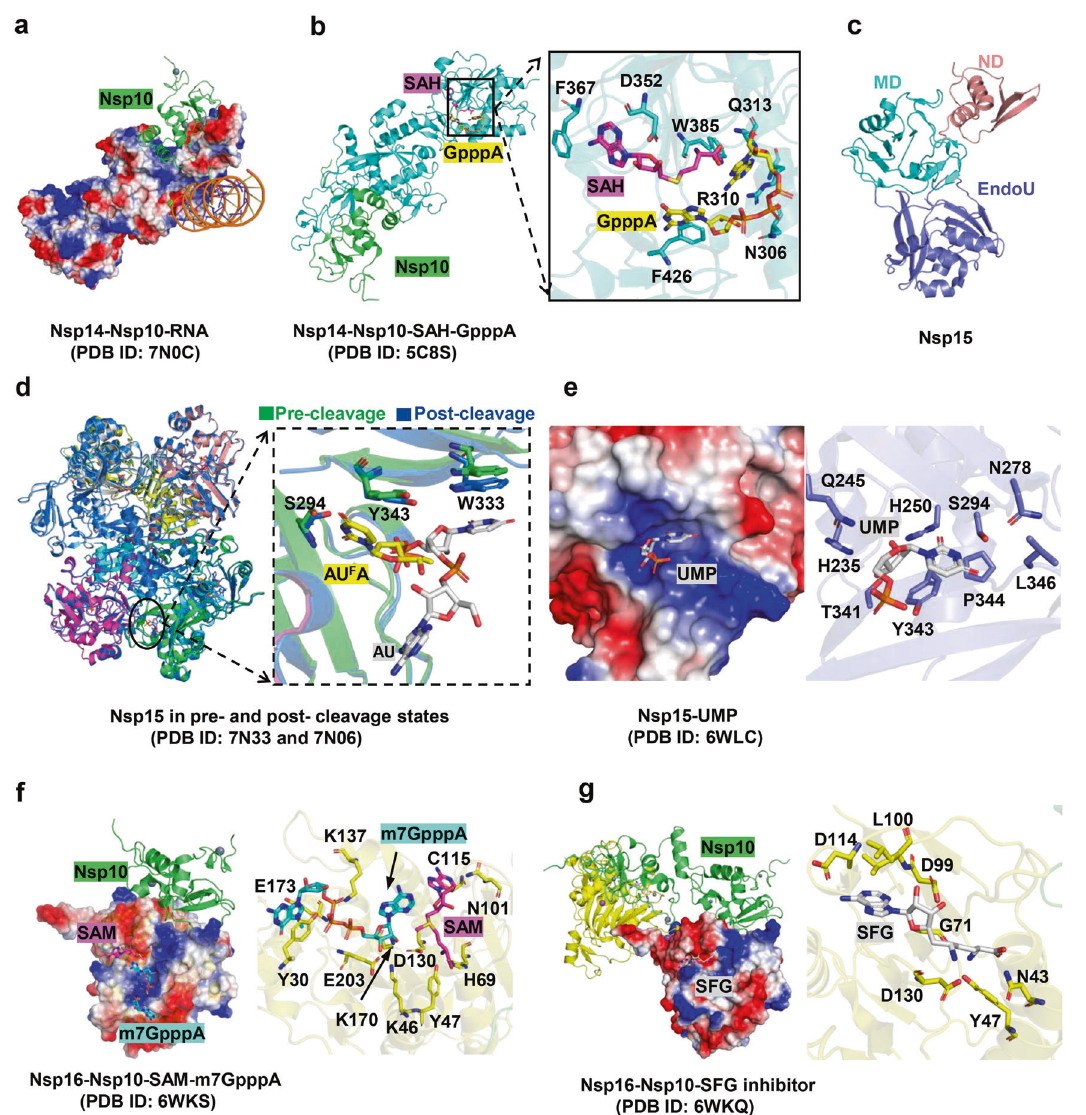
Fig. 7 Structures of Nsp14 /Nsp15/Nsp16 and their inhibitors. a Cryo EM structure of the SARS-CoV-2 Nsp10-Nsp-14 RNA complex. Nsp14 is illustrated with electrostatic surface. Nsp10 is illustrated with cartoon in green. b The structure of the Nsp14-Nsp10 in complex with functional ligands S-adenosyl-L-homocysteine (SAH) and GpppA shown in sticks. c The overall structural of Nsp15. d Conformational changes between Nsp15 in pre- and post- cleavage states. e Structures of Nsp15 in complex with uridine-5 ′ -monophosphate (UMP). f The structure of SARS-CoV- 2 Nsp16-Nsp10 in complex with RNA cap analogue (m7GpppA) and S-adenosyl methionine (SAM). The m7GpppA and SAM are shown in sticks. Nsp16 is indicated as electrostatic surface. g The structure of Nsp16-Nsp10 heterodimer in complex with sinefungin (SFG). SFG is shown in sticks. Nsp16 is illustrated with electrostatic surface and cartoon in